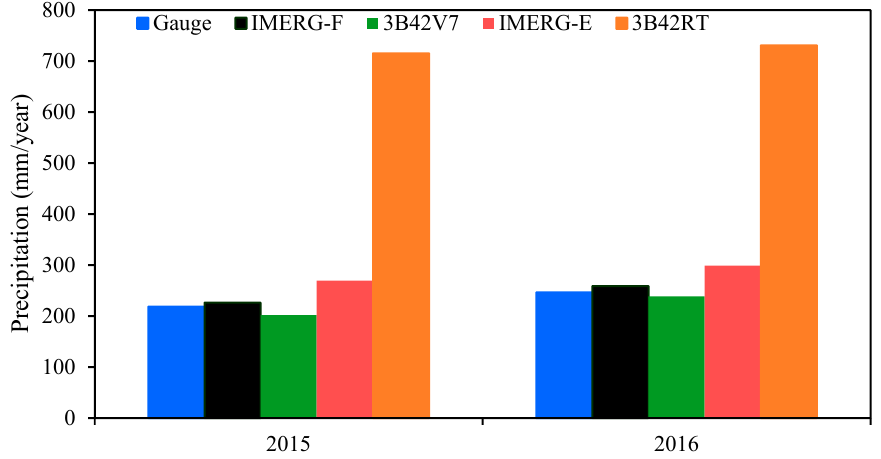
Figure 6. Comparison of average annual gauge-based observations with the IMERG-E, IMERG-F, 3B42V7, and 3B42RT estimates over the Tianshan Mountains during 2015 and 2016.